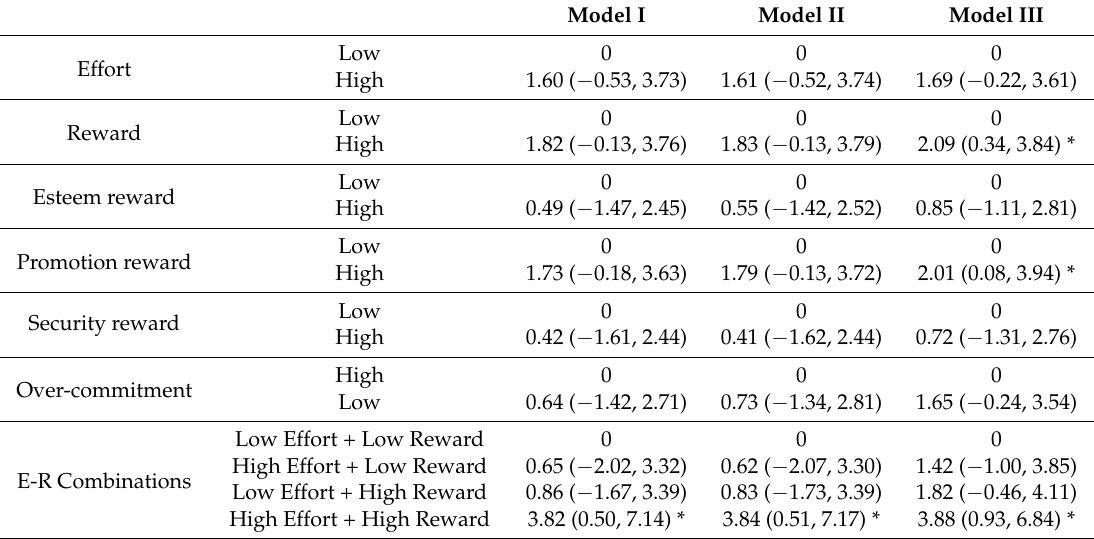
Model III: Model II + additionally adjusted for physical health and mental health in 2006. Table 3. Associations of ERI in 2006 with changes in verbal fluency (Animal Naming Test) during 2006–2012 ( n =